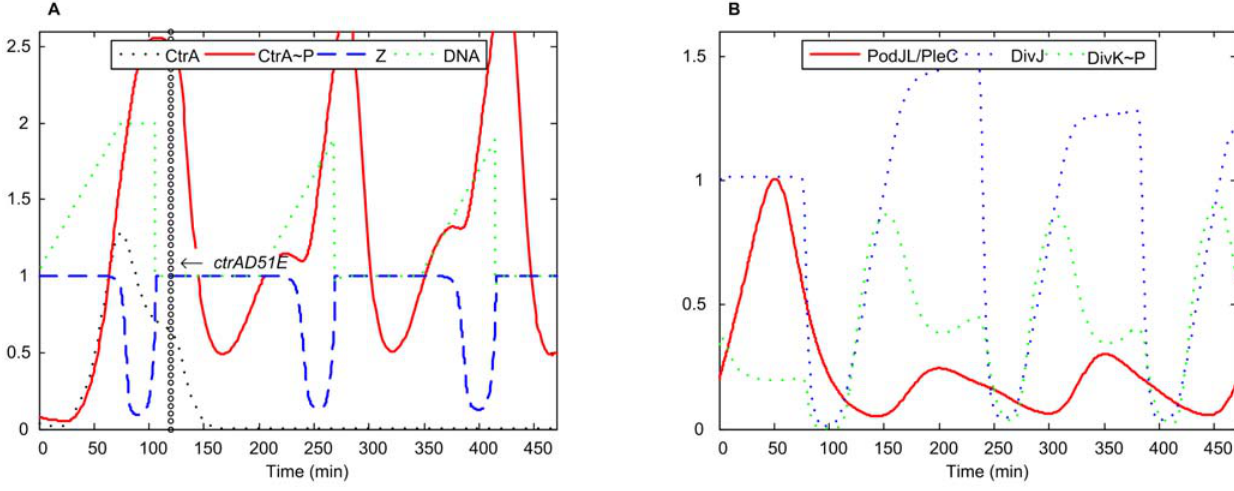
Figure 5. Simulation of ctrAD51E mutant. k s,ctrA-P1 = k s,ctrA-P2 =0, k trans,CtrA , P =0, k 9 =0.064 (40% of WT) was added to [CtrA , P] equation. The vertical column of open circles here and on subsequent figures indicates the time at which the mutation is introduced. For earlier times the simulation is run with wild-type values of all parameters.